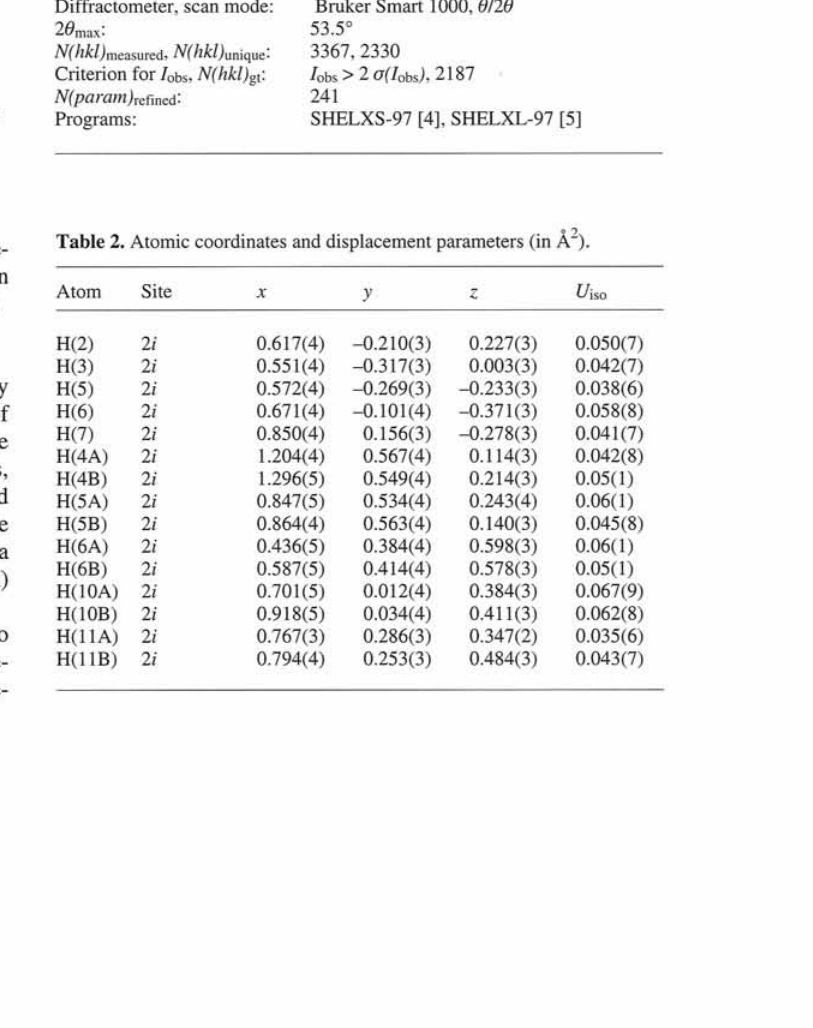
Table 1. Data collection and handling.